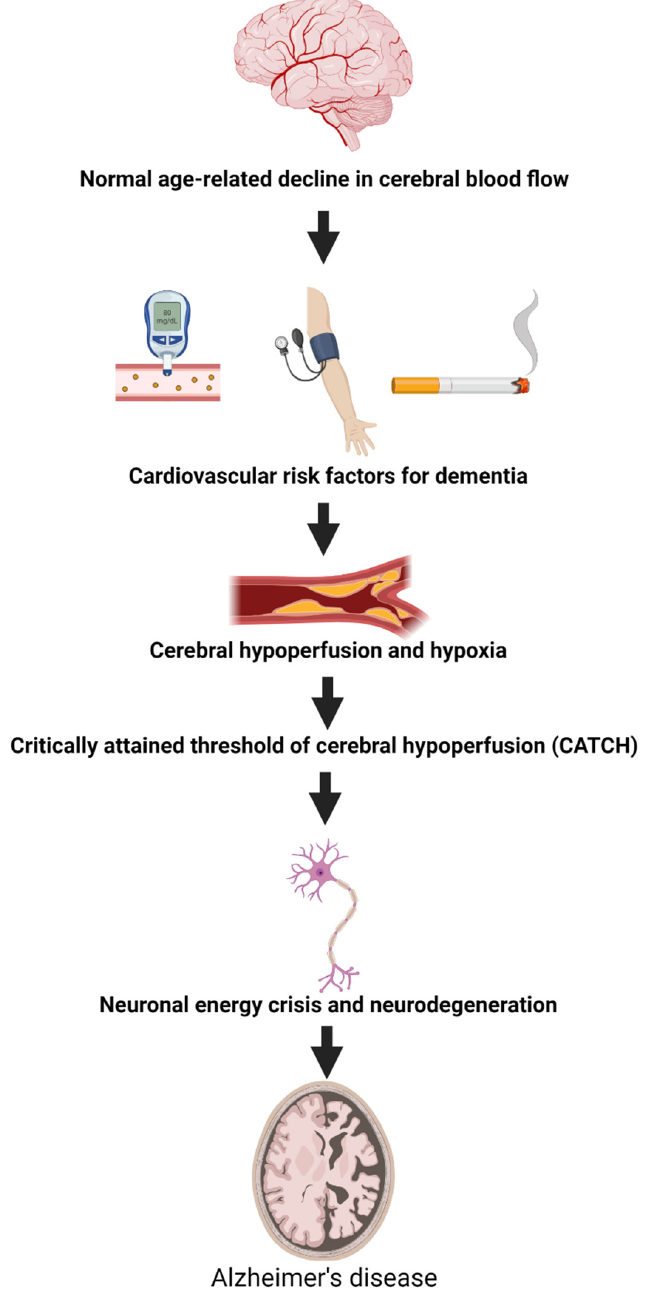
Figure 6. The vascular hypothesis of Alzheimer’s disease. Normal ageing causes a decline in cerebral blood flow (1). The existence of cardiovascular risk factors such as smoking, high blood pressure, and diabetes will worsen this decline (2) leading to cerebral hypoperfusion and hypoxia (3). At one point a critical threshold of cerebral hypoperfusion is reached (4) leading to neuronal energy crisis and neurodegeneration (5), eventually causing Alzheimer’s disease (6). Adapted from de la Torre Journal of Alzheimer’s disease 2018 [158].